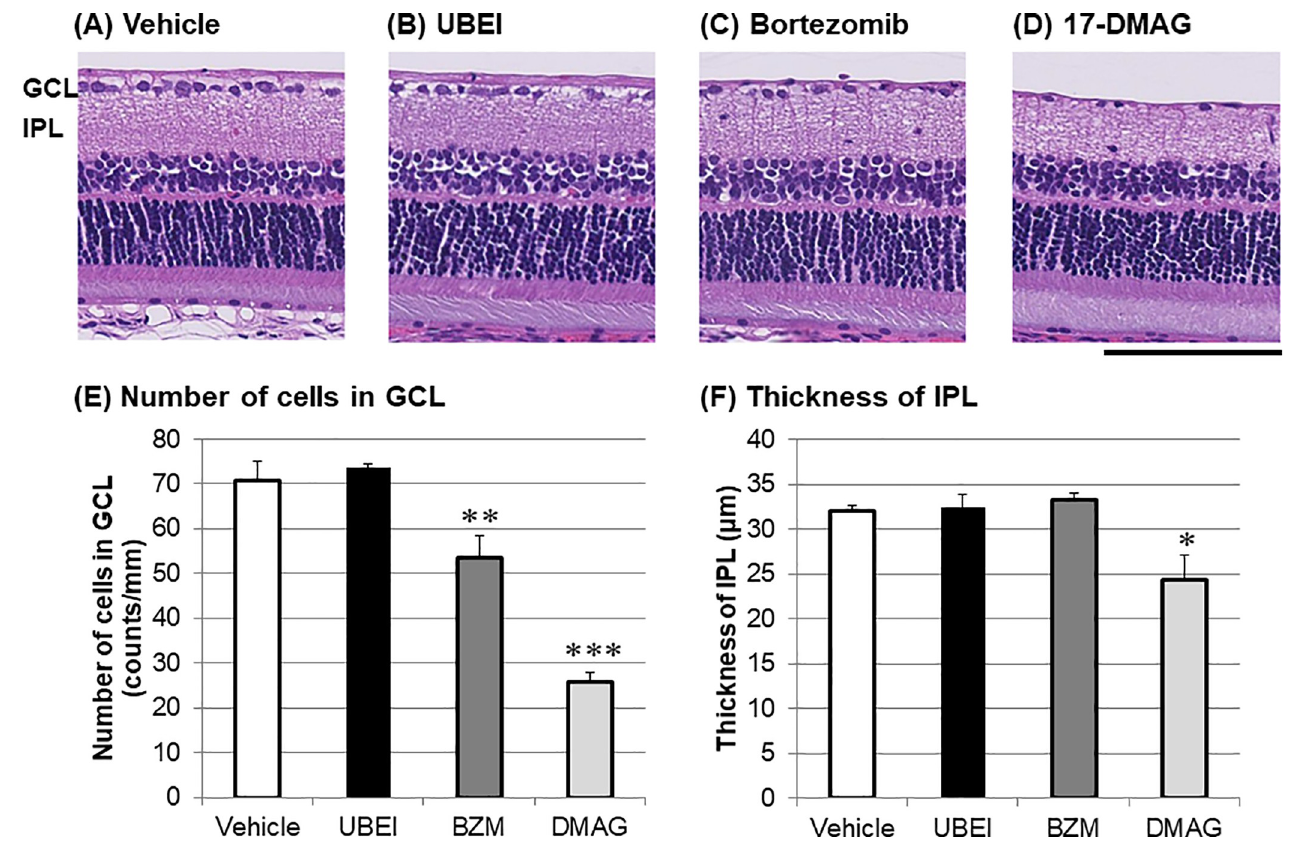
Fig 3. Retinal degeneration induced by bortezomib (BZM) and 17-DMAG (DMAG) in the normal adult rat eyes. Each photograph shows the representative image of cross-sectioned retina 7 days following intravitreal injection of vehicle (A, D-PBS), UBEI-41 (UBEI, B: 12.5 nmol/eye), BZM (C: 1 nmol/eye), and DMAG (D: 25 nmol/eye). The scale bar shows 100 μ m. The lower left and right panels show the number of cells in the ganglion cell layer (GCL, E) and the thickness of the inner plexiform layer (IPL, F), respectively. Each value represents the mean ± S.E.M. of 4 eyes from 2 animals. � P < 0.05; �� P < 0.01; ��� P < 0.001, compared with vehicle by Dunnett’s multiple comparison